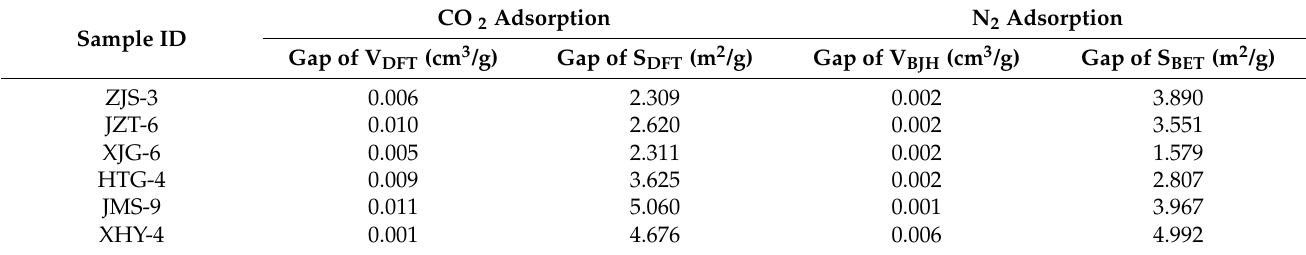
Table 4. Gap values between the micropore and mesopore PVs and SAs in the extracted samples and original shales. Sample ID